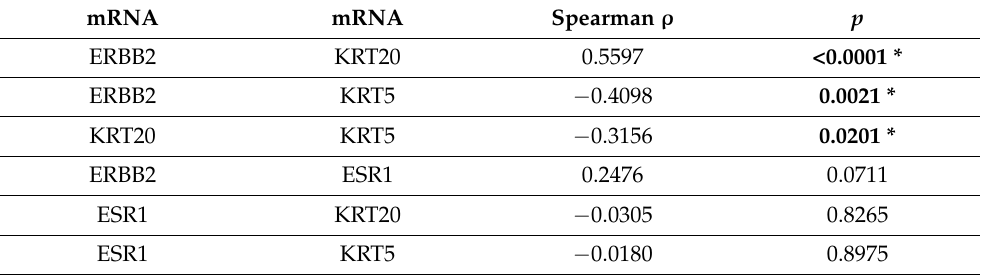
Table 4. Spearman correlation analyses of KRT5, KRT20, ERBB2 and ESR1 mRNA expression before neoadjuvant chemotherapy, significant results are marked with